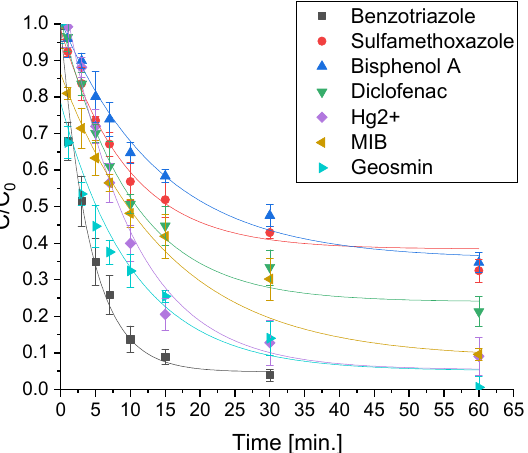
Figure 8. Degradation curves obtained for the mixture of contaminants using ZnO-CeO 2 -Cu 2 O as photocatalyst in aquaculture water.